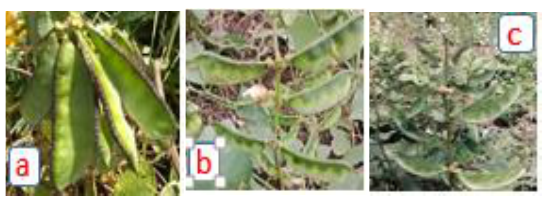
Figure 5. Pictorial presentation of the different morphological characters of lablab.